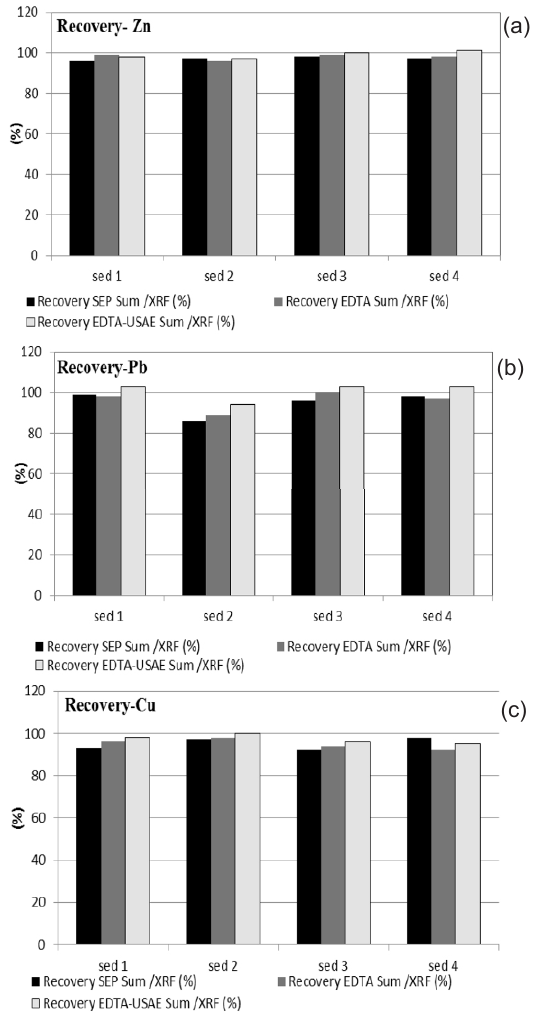
Figure 3. The comparison of the recoveries of the SEP (labeled as Recovery SEP Sum /XRF), conventional EDTA extraction (Recovery EDTA Sum /XRF), and ultrasonically assisted EDTA extraction (Recovery EDTA-USAE Sum